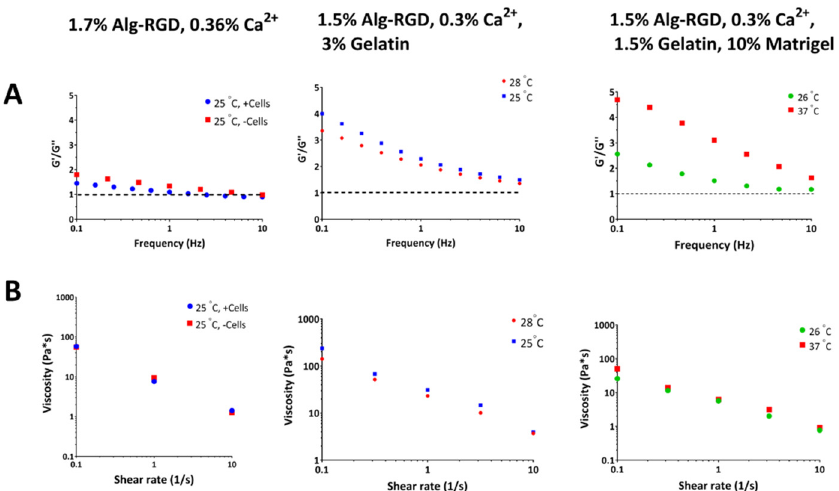
Figure 2. Viscoelastic responses of bioink solutions for cell-laden core 3D bio-printing. ( A ) Repre- sentative mechanical spectra of different core bioink solutions at different temperatures. The small-deformation oscillatory measurements are presented in terms of the storage modulus G ′ (elastic response) and the loss modulus G ′′ (viscous response), as a function of angular frequency. G ′ is used as the primary indicator of a gel-like (structured) system. In crosslinked unmodified alginate, at low angular frequencies, G ′ values exceed G ′′ and with the increase in frequency, a cross-point appears. This is typical of an “entanglement network” type of chain interactions. ( B ) viscosity (bottom row) of different core bioink solutions at different temperatures.